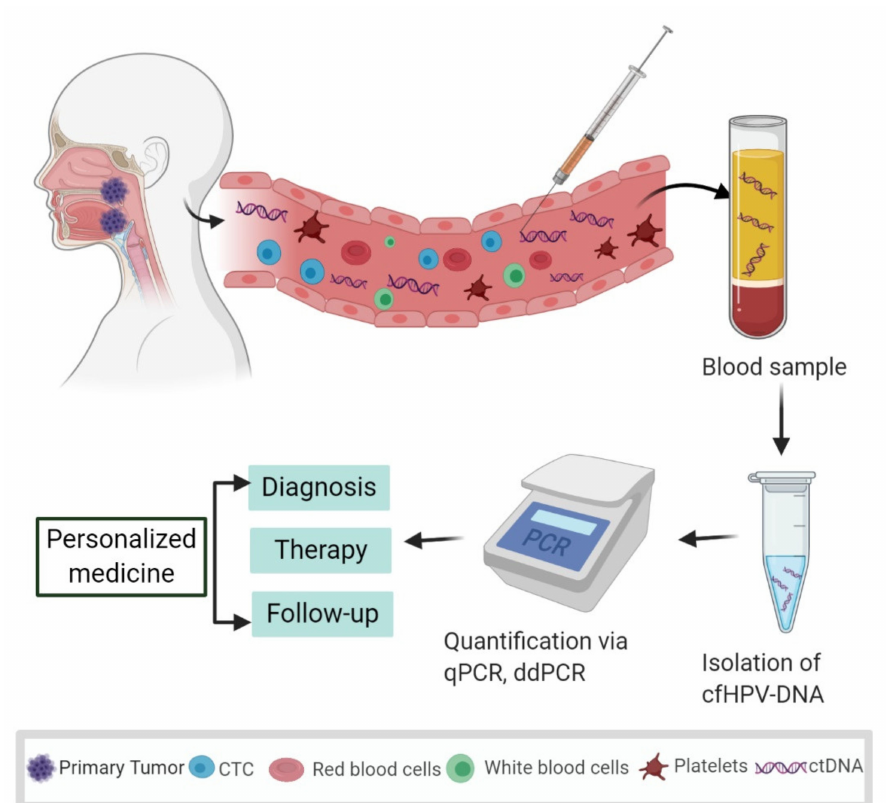
Figure 1. Systematic representation of the process and potential usage of liquid biopsies as a biomarker in oropharyngeal squamous cell carcinoma (OPSCC). Human papillomavirus (HPV) infects the palatine tonsil and the base of the tongue, causing HPV-related OPSCC. Tumor cells and tumor-derived DNA end up in the bloodstream that may function as a biomarker to facilitate personalized medicine. By obtaining blood plasma and isolating the cell-free DNA (cfDNA), quantification methods such as qPCR (quantitative PCR) and droplet digital PCR (ddPCR) make it possible to detect and quantify cell-free HPV-specific DNA (cfHPV-DNA) sequences for diagnosis, therapy stratification, and disease monitoring. Designed with